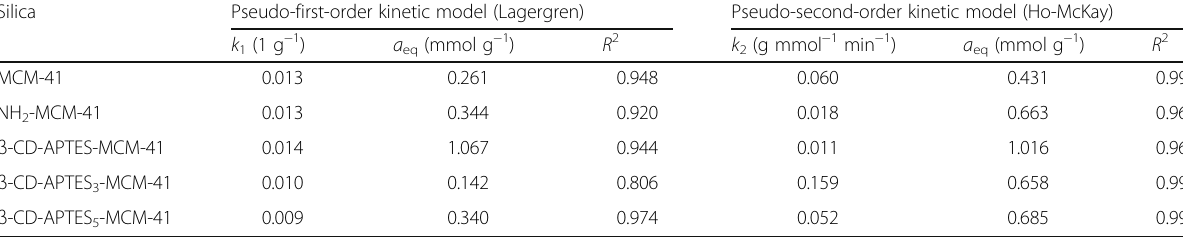
Table 2 Kinetic parameters of benzene adsorption on MCM-41 silicas Silica Pseudo-first-order kinetic model